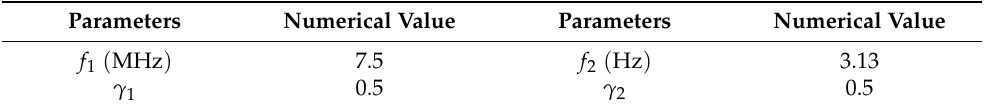
Table 2. Jamming simulation